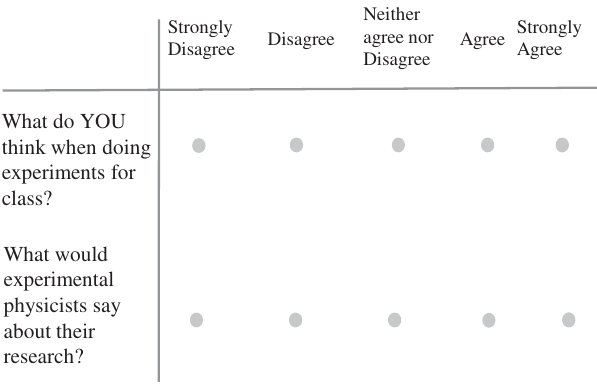
FIG. 1. An example of one of the five E-CLASS prompts along with the open-ended bids for students to explain their Likert-scale